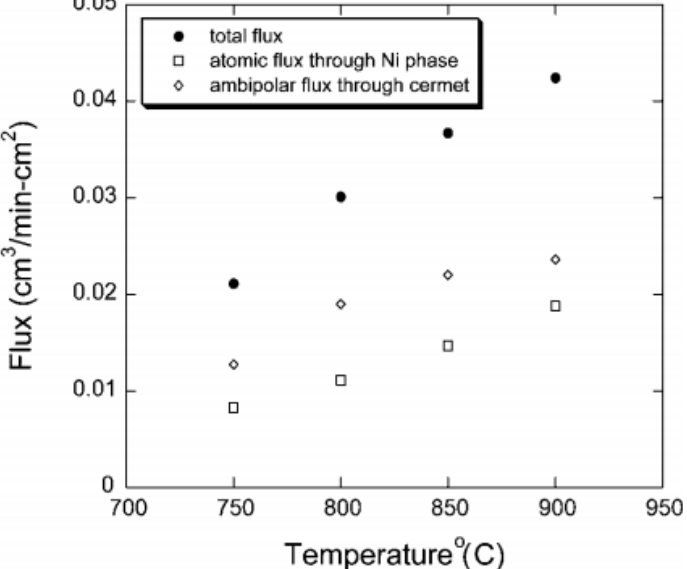
Figure 4. The contribution of two diffusion mechanisms to the total hydrogen permeation fluxes in Ni-SCYb cermet dual-phase membranes [52].